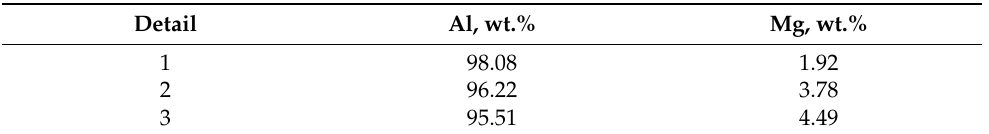
Table 5. The results of the EDS analysis of the solution-hardened sample performed on the details indicated in Figure